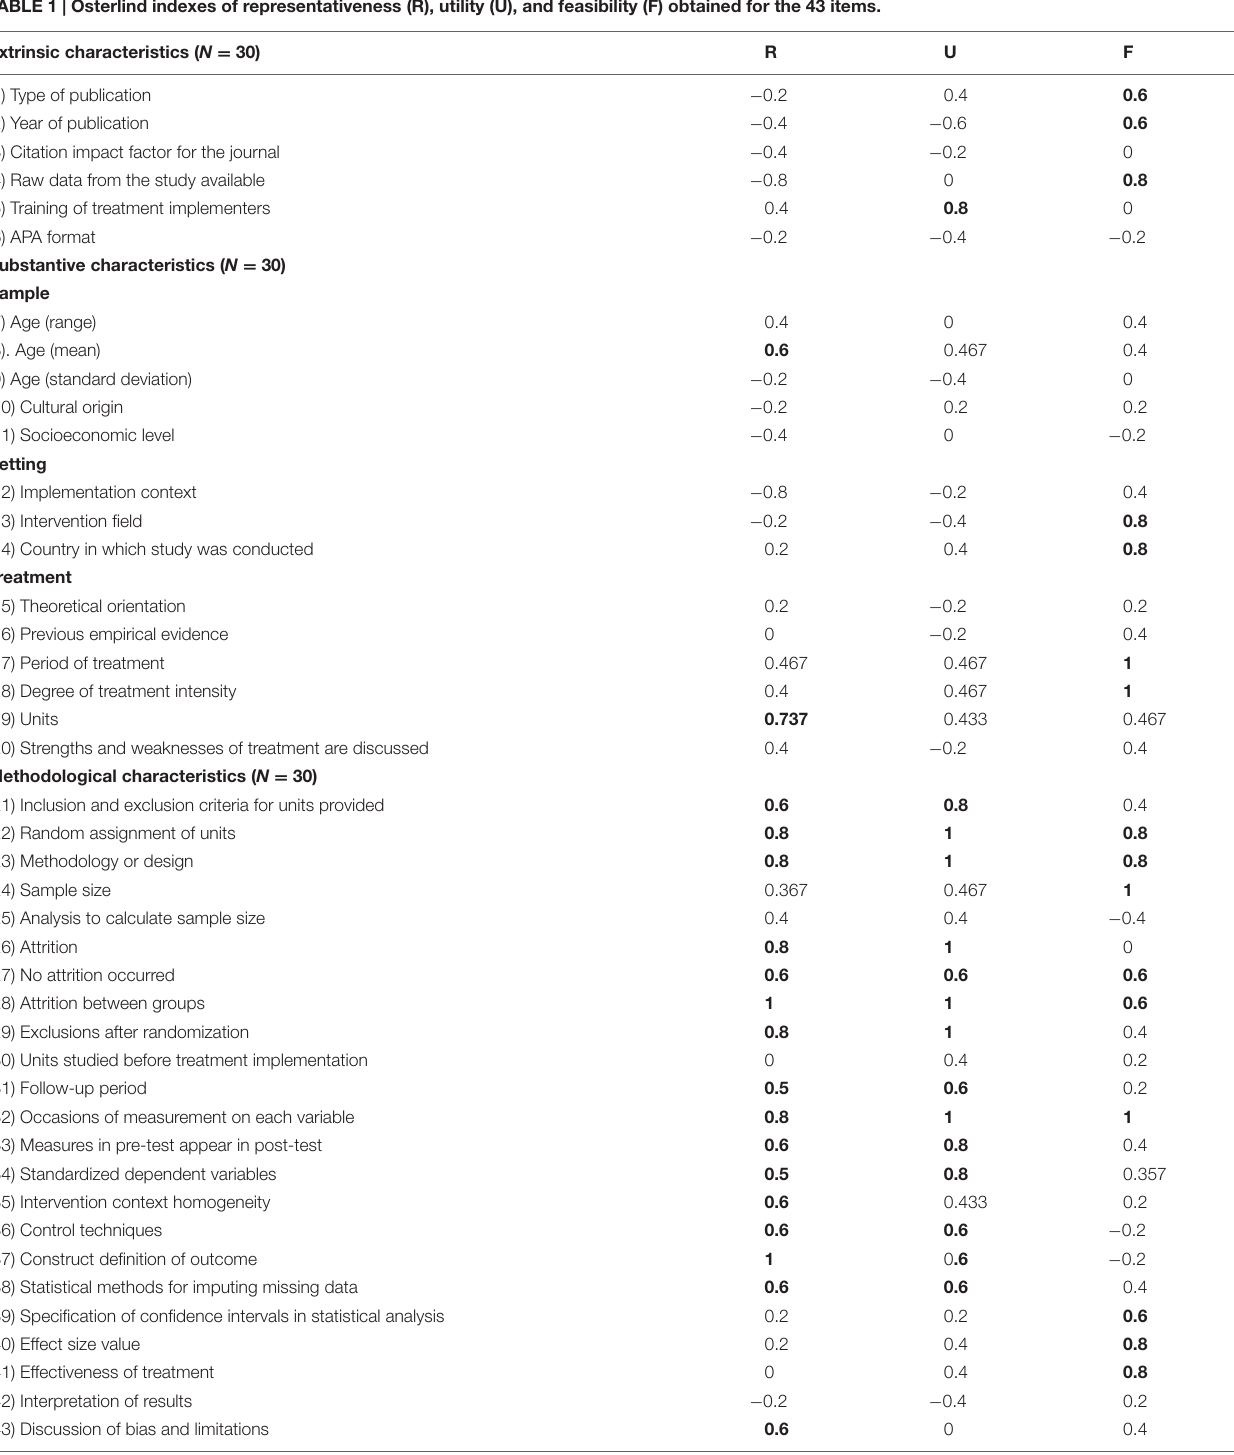
TABLE 1 | Osterlind indexes of representativeness (R), utility (U), and feasibility (F) obtained for the 43 items. Extrinsic characteristics ( N =